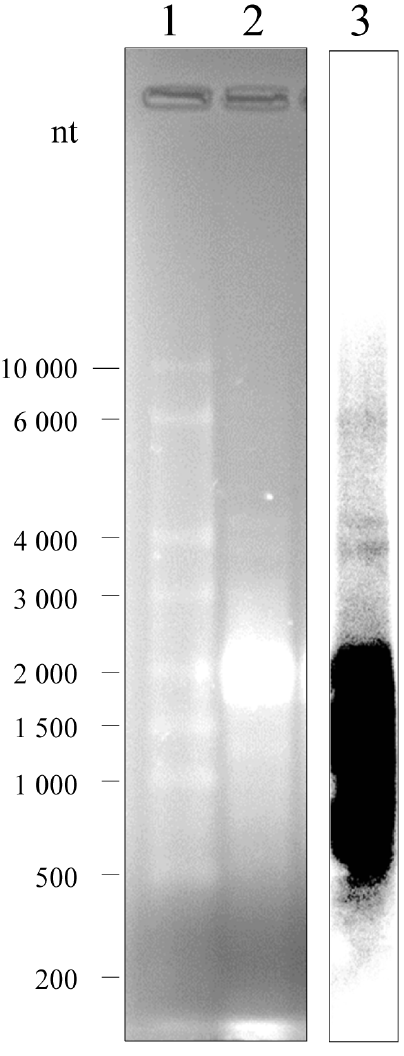
Figure 4. Northern blot analysis of LNCR expression in S. frugiperda adults. Total RNA (15 micrograms) extracted from S. frugiperda adults was denatured, separated on 1.2% agarose gel (lane 2), together with RNA ladder (lane 1) and stained with EtBr. Molecular sizes of RNA ladder (in nucleotides) are indicated on the left of the figure. The RNA was blotted onto nylon membrane and hybridized with a 32 P-labeled LNCR specific DNA probe. The probe (1244 bp) was generated with ncRNA_long primers (see Material and Methods) by PCR, using cDNA of adults as template. Northern blot is shown in lane 3.